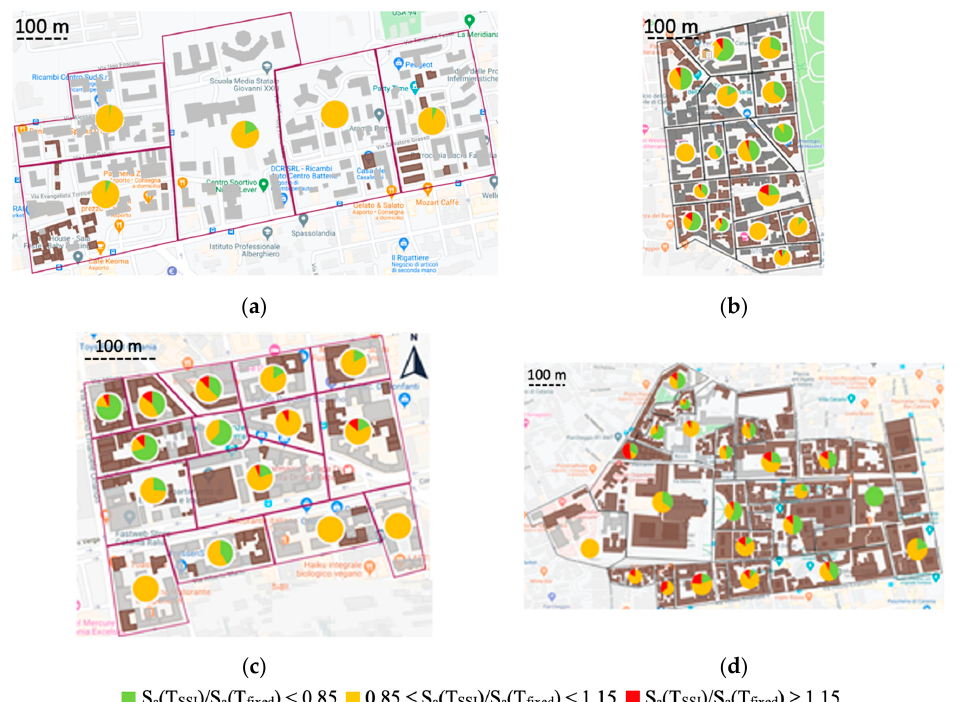
Figure 10. Spatial distribution of S a ( T SSI ) /S a ( T fixed ) ratios for the 1818 seismic input: ( a ) west area; ( b ) northeast area; ( c ) north Old Town; ( d ) south Old Town.